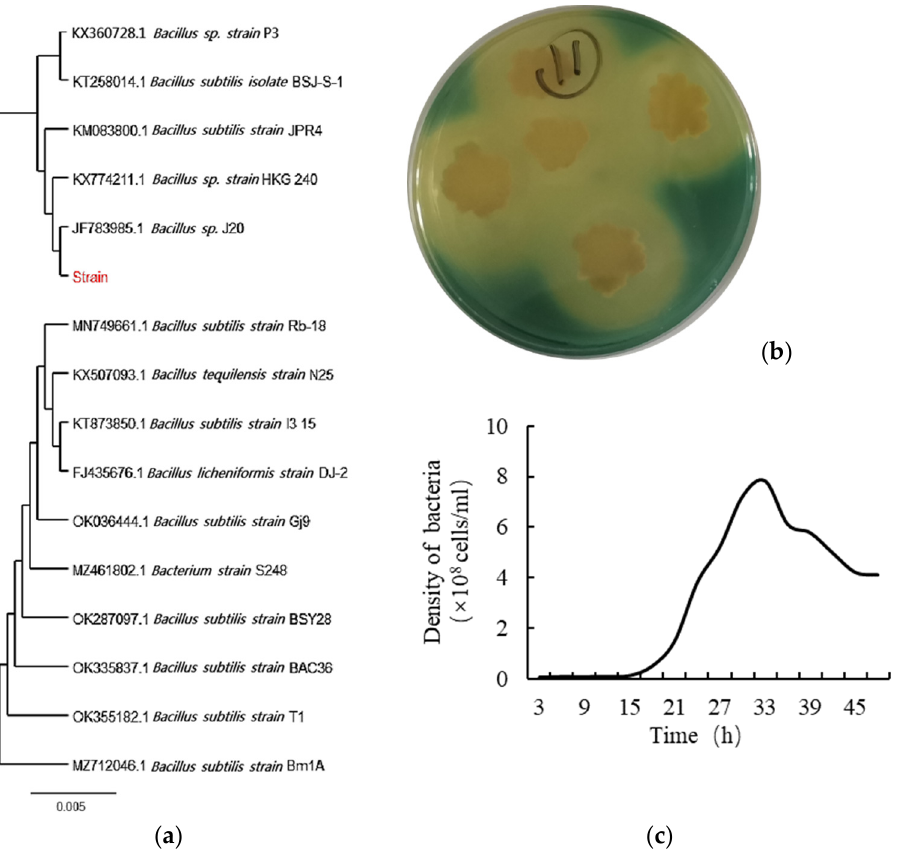
Figure 1. Phylogenetic tree (( a ), the word marked in red is Strain11), CAS test results of siderophore production ability ( b ), and growth curve ( c ) of Strain11.